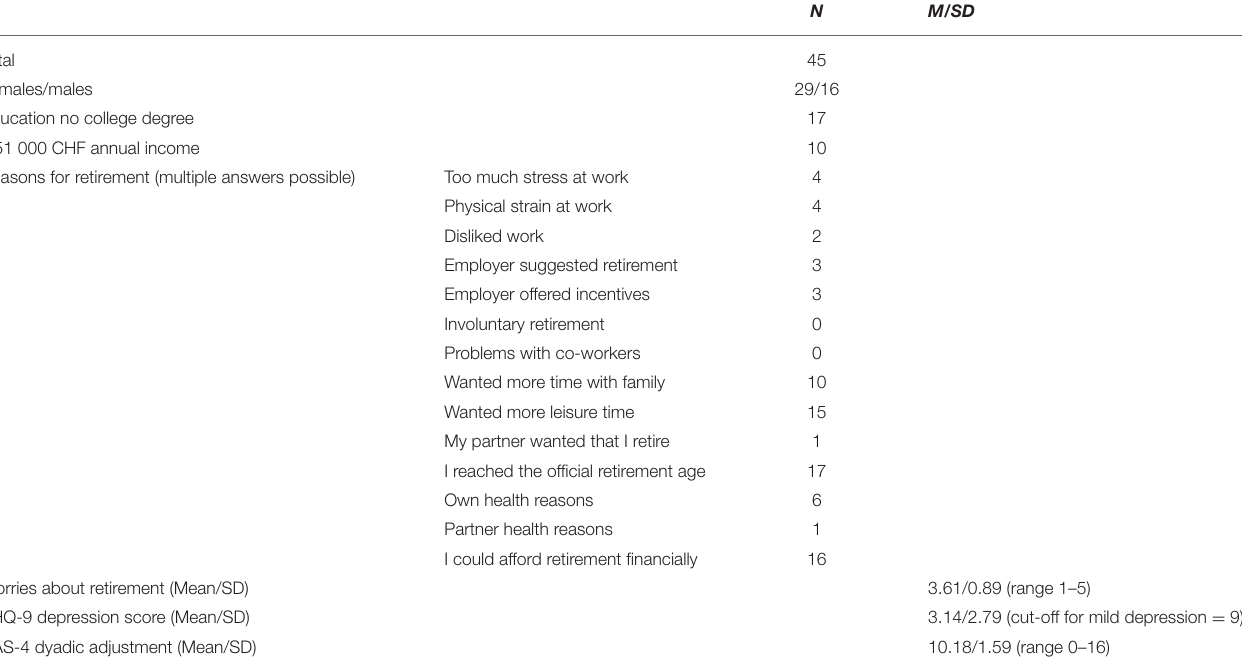
TABLE 1 | Characteristics of the recently retired